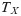
General transmission dynamics of any infectious disease at individual level in INFEKTA.Probabilities are individual based and are defined according to the infectious diseases and characteristic such as current location, age, gender, and so on. Symbol ⌚, on state X, indicates that an individual must stay some period of time TX at such state X before being able to change to other state. Symbol ✉, indicates that individuals on state X can infect Susceptible (S) individuals.